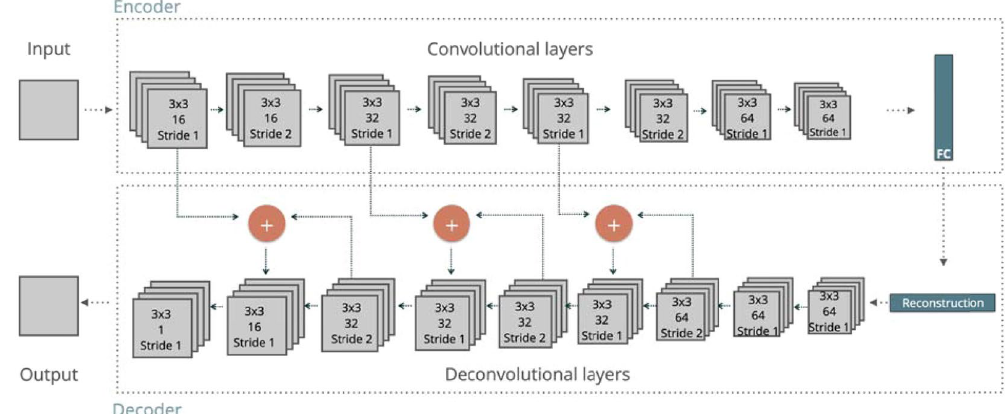
Figure 13. The architecture of the convolutional neural network for data recovery. All the convolutional and deconvolutional layers use 3 × 3 kernels and ReLU as activation